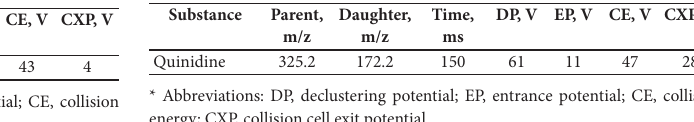
Table 6. Multiple reaction monitoring (MRM) parameters of